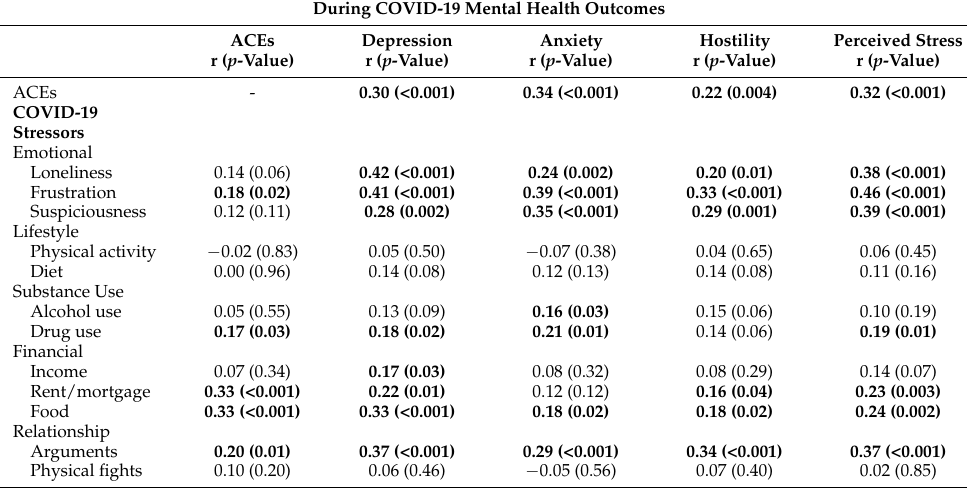
Table 2. Pearson correlations between adverse childhood experiences (ACEs), COVID-19-related stressors, and mental health outcomes during COVID-19 1